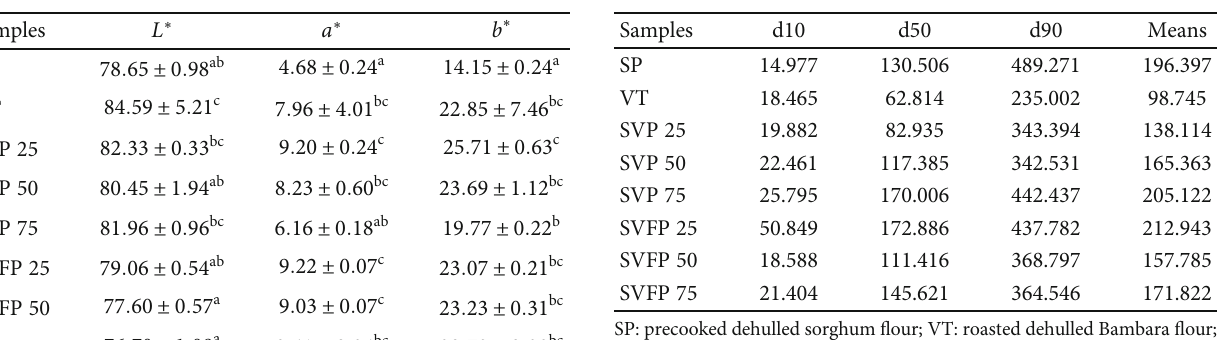
Table 3: Colour of fl ours. Table 4: Particle size distribution parameters ( μ